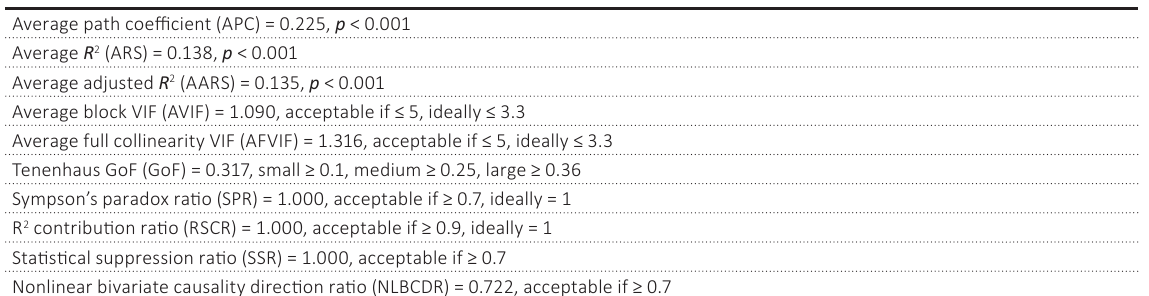
Table 6. Model fit and quality